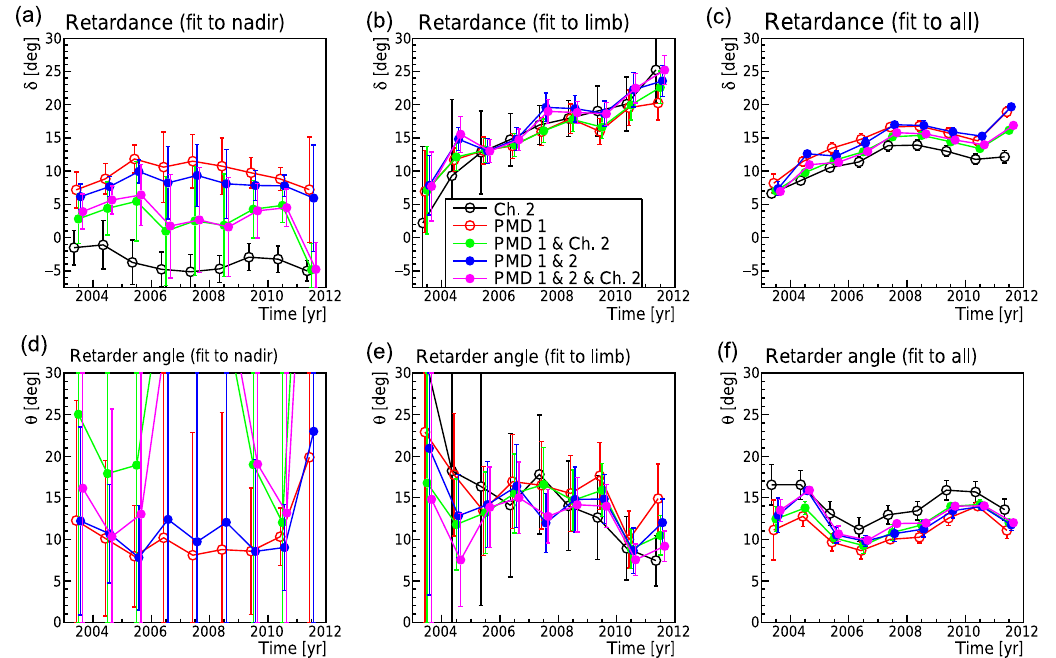
Figure 15. Fit results for the parameters δ (a, b, c) and θ (d, e, f) vs. time using only nadir (a, d) , only limb (LUT method for the PMDs, b, e ), or limb and nadir combined (c, f) . The different colors are for different combinations of detectors.